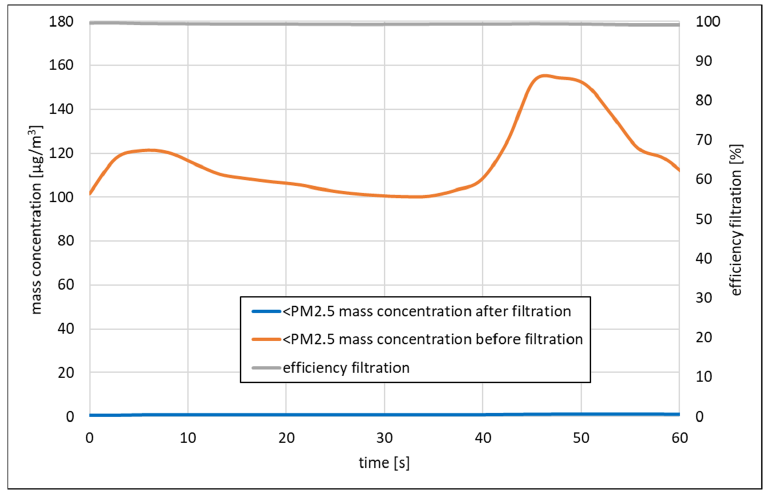
Figure 9. The change in mass concentrations of dust after application of activated carbon layer + F5 filter + EPA11 filter regarding filtration efficiency (temperature: 14 °C, relative humidity: 42%).